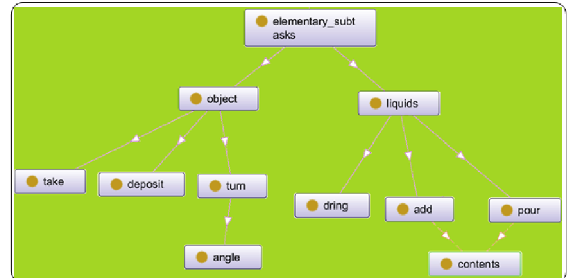
Fig. 10. Some possible elementary subtasks for liquid and objects